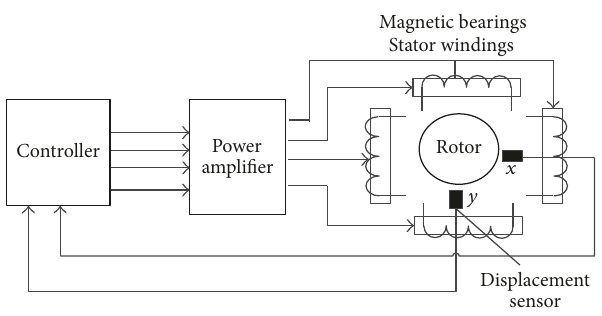
Figure 1: The working principle of an active magnetic